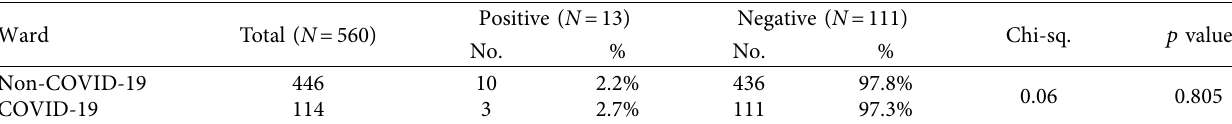
Table 9: Comparison of COVID-19 IgG between non-COVID-19 emergencies and COVID-19 ward healthcare workers.